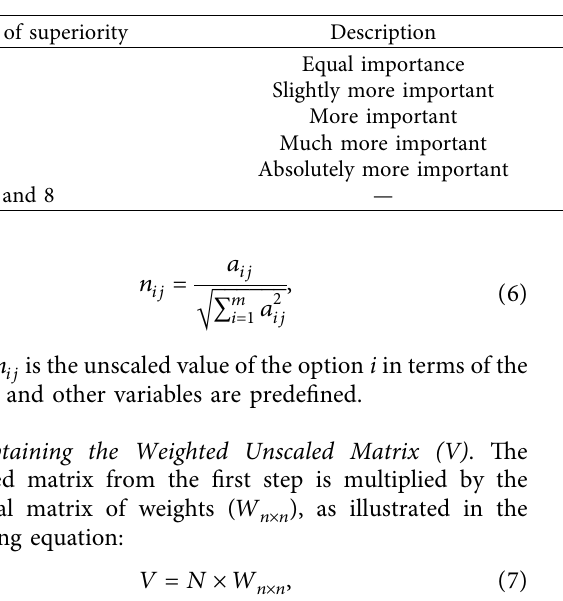
Table 1: Preference values for pairwise